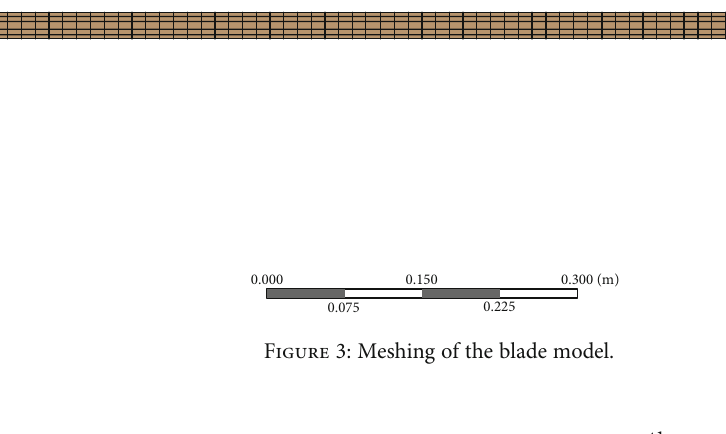
= 1 : 15 , ω = 1 : 5 , and ω == 3 : 0 ). w v ϕ